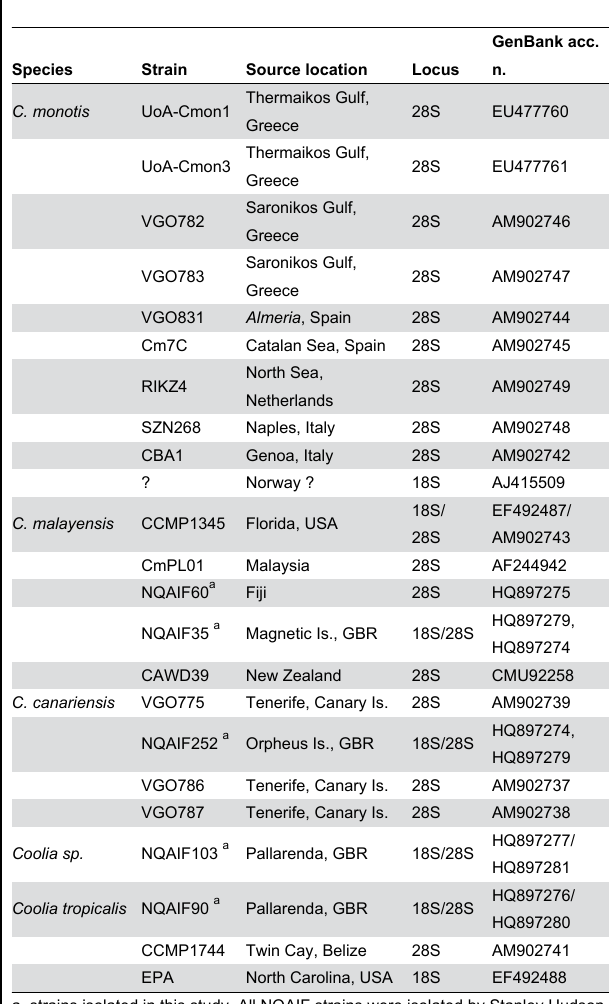
Table 5. Strains of Coolia spp. used for phylogenetic